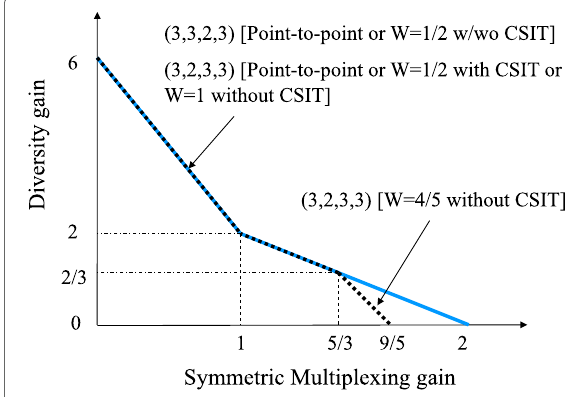
Fig. 14 The symmetric DMT of MIMO full-duplex network without side channel for α dl = α ul = α I = 1